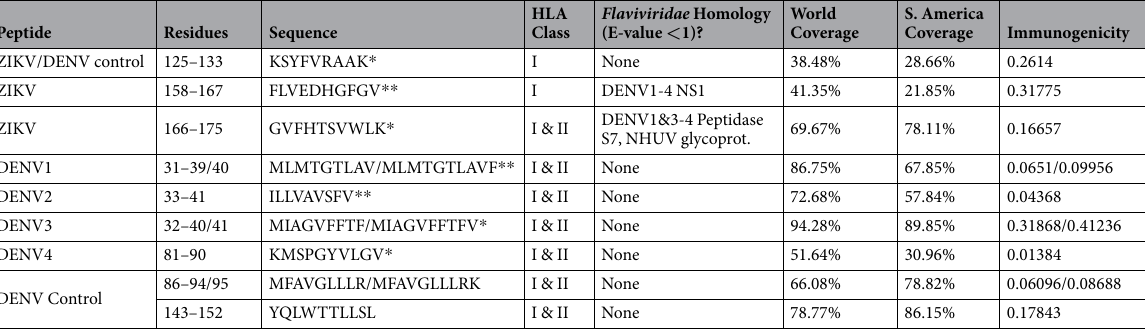
Table 3. Proposed diagnostic kit peptide summary. * Exact MHC-NP match. ** Near MHC-NP match. Immunogenicity > 0 is the threshold for predicted